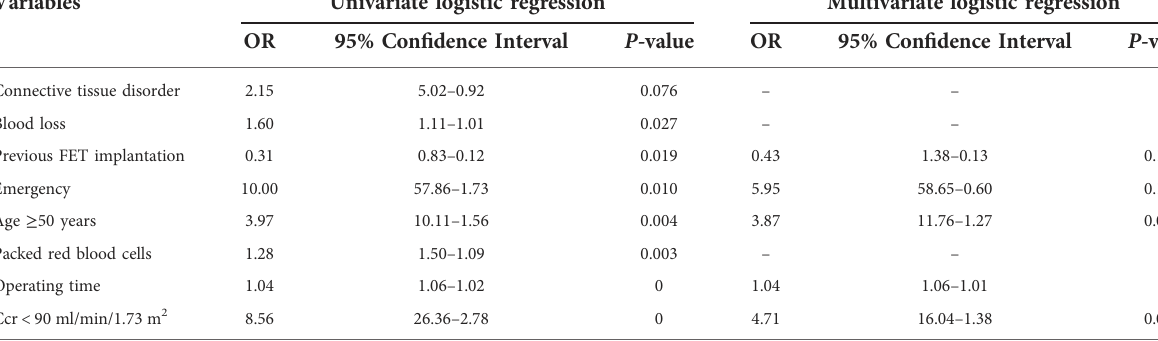
TABLE 4 Logistic regression analysis for adverse